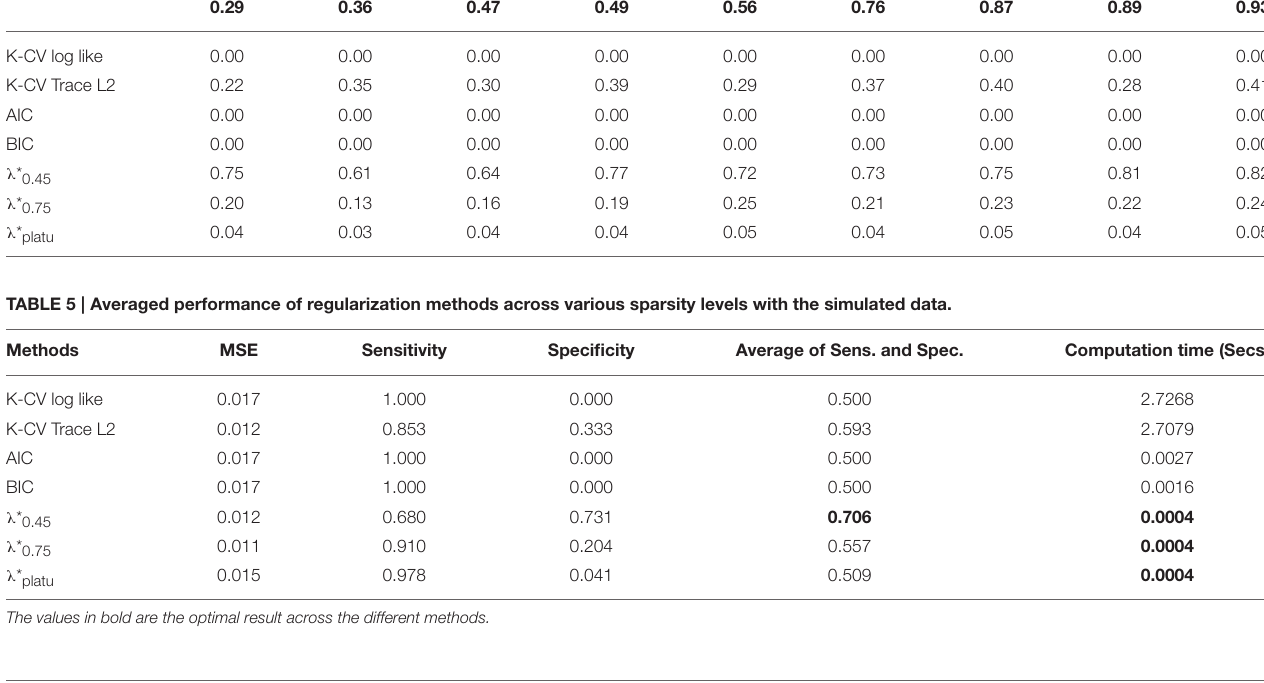
TABLE 6 | Comparison of computational time to select the tuning parameter for one randomly selected subject from the PNC study using different regularization selection methods.